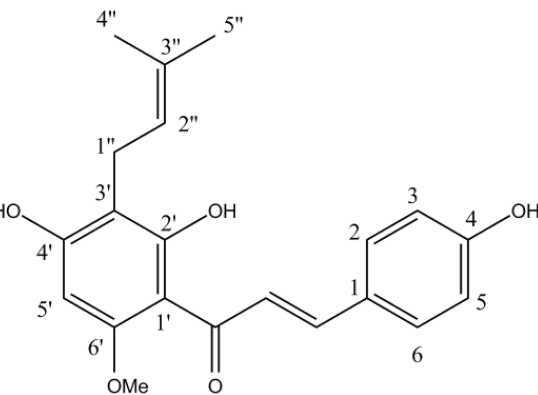
Figure 5. Xanthohumol chemical structure.